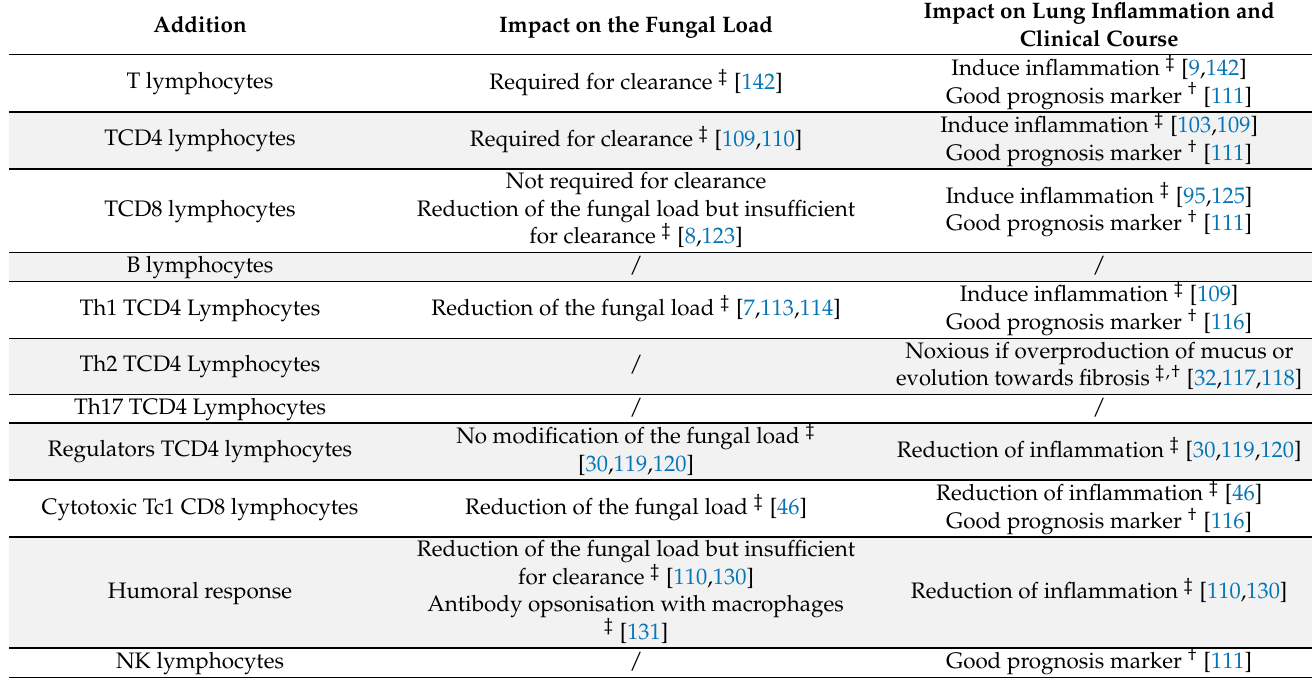
Table 2. Role of immune cells during PCP on fungal load and outcome of the